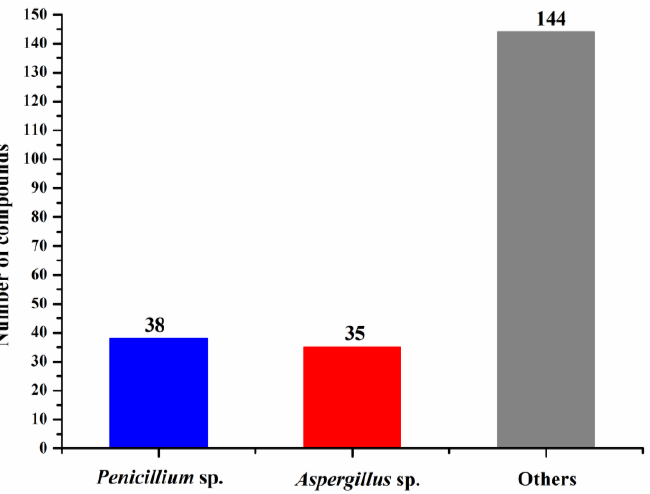
Figure 10. Numbers of new halogenated compounds from different marine fungi (1994–2019). Molecules 2020 , 25 , x FOR PEER REVIEW